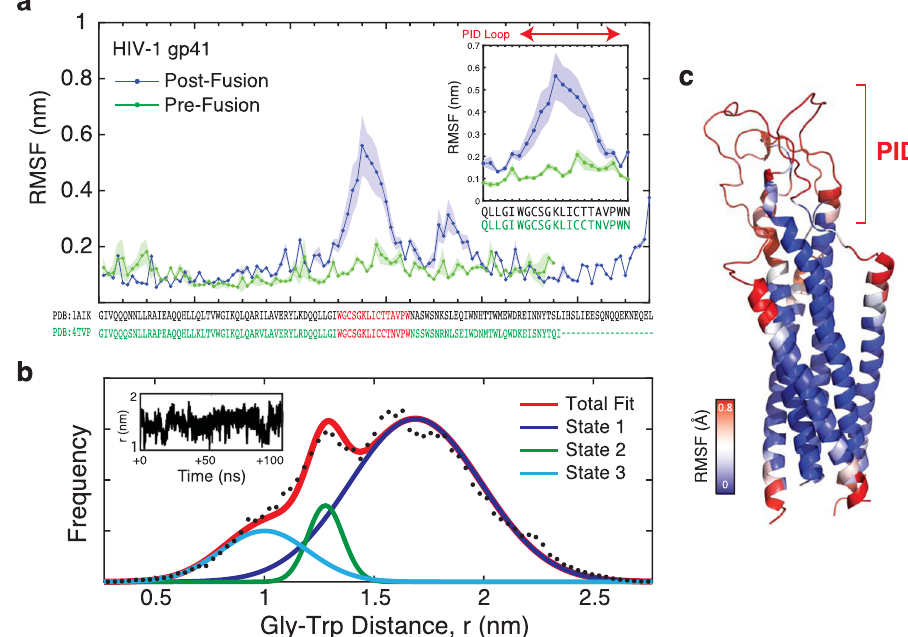
Fig. 6 Conformational plasticity of the HIV-1 gp41 ectodomain. a MD simulation of a homology model of the complete HIV-1 gp41 ectodomain. RMSF plot versus residue show fl exibility of the PID region in the HIV-1 gp41 post-fusion state, but not the pre-fusion conformation. The inset panel shows an expanded view of the RMSF structural fl uctuations in the PID region between the pre- and post-fusion conformations. b Analysis of the MD simulation of the PID region in the HIV-1 gp41 ectodomain. Raw data showing the frequency of end-to-end distance measurements between Gly600 and Trp610 of the PID region (black dots) are used to calculate an overall total fi t (red curve). Potential metastable states are deconvoluted from the total fi t, as estimated by distinct Gaussian distributions. Upon fi tting, three metastable conformations are observed, with the most populated state centered at 1.8 nm (State 1) and two additional minor states at 1.3 nm and 1.0 nm (State 2 and State 3). This suggests that the PID region adopts a distribution of conformations in simulation. c Structure of the homology model of the HIV-1 gp41 ectodomain superimposed with a heat map of RMSF displacements (in Å) over the course of the MD simulation. Regions of the highest fl exibility are highlighted in